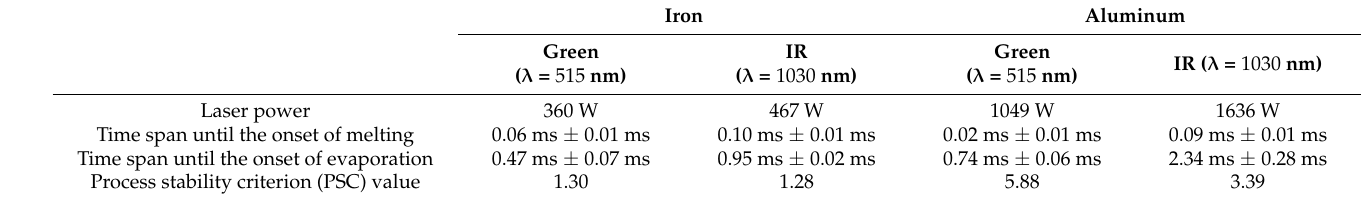
Table 2. Heat-up time spans until melting and evaporation is reached for iron and aluminum. The laser powers were chosen such that the spot welds featured equal mean-welding